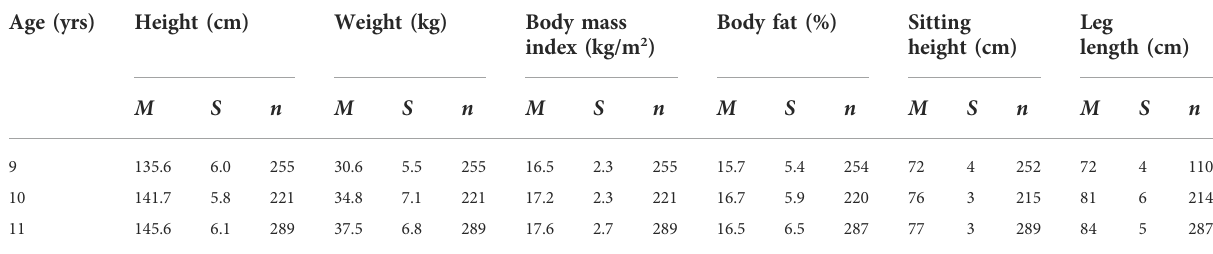
TABLE 1 Summary of